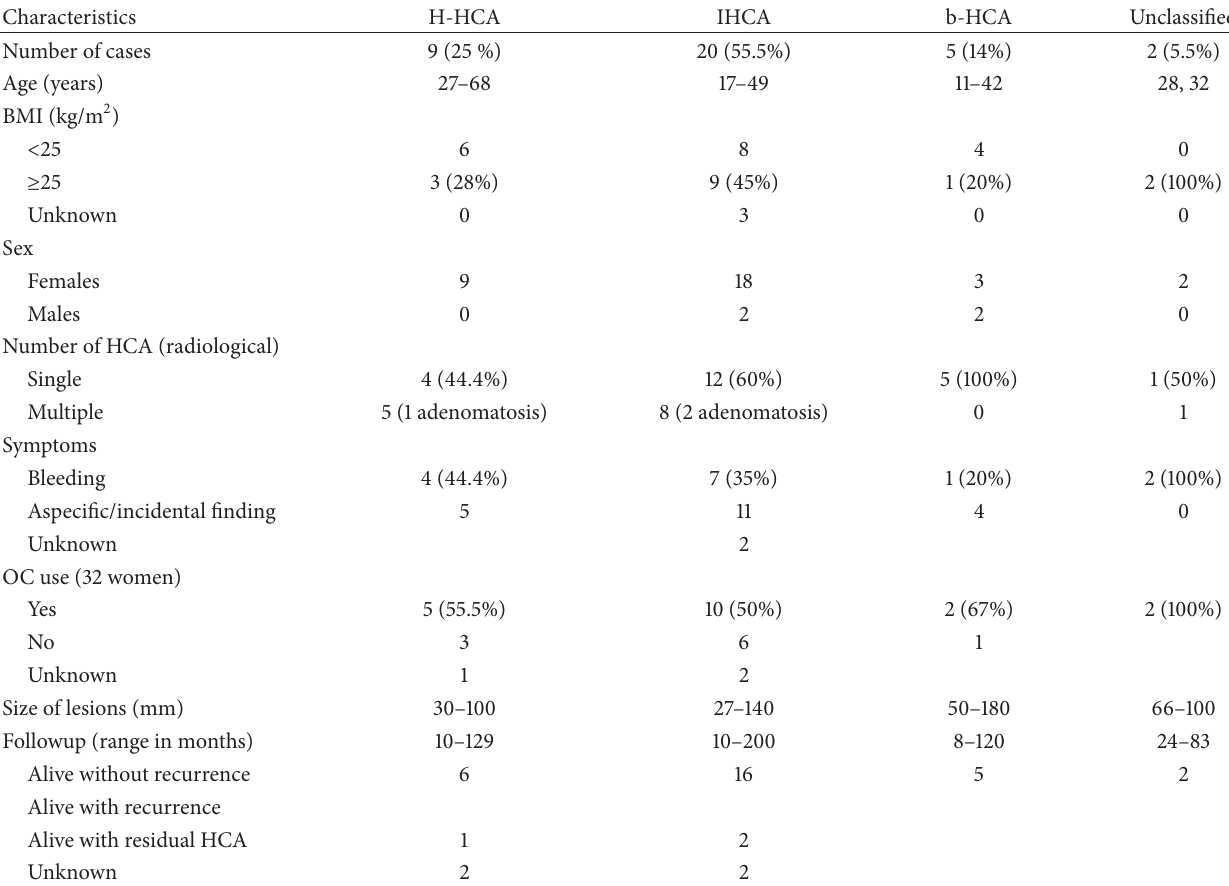
Table 2: Clinical data according to hepatocellular adenoma subtypes. (The patient with both H-HCA and IHCA is not included in the table.)